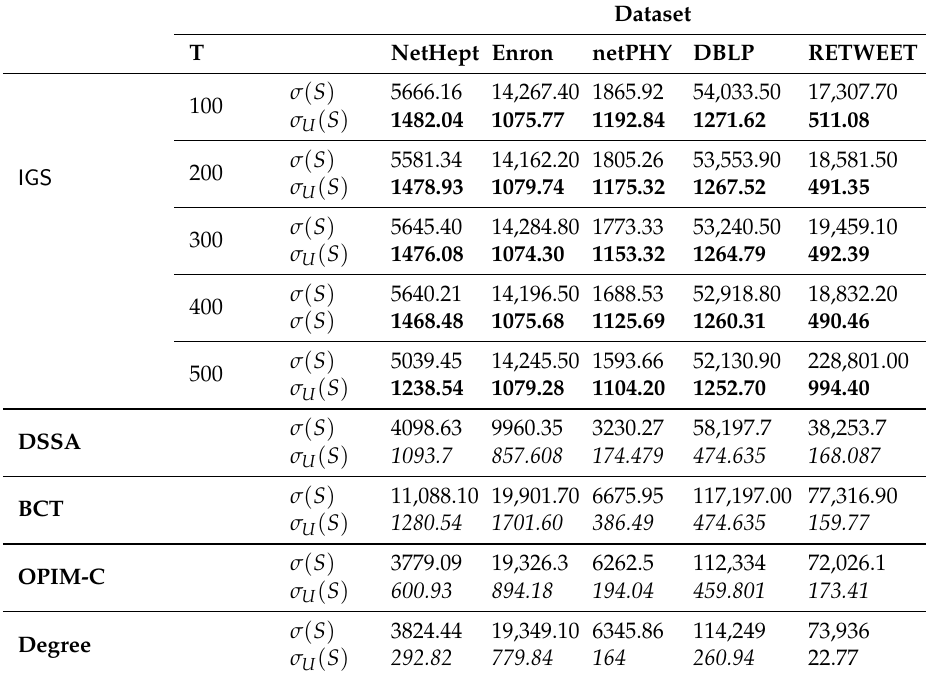
Table 2. Comparisons about σ ( S ) and σ U ( S ) between IGS and the others with k = 500, U size = 1 K and T = 100 →